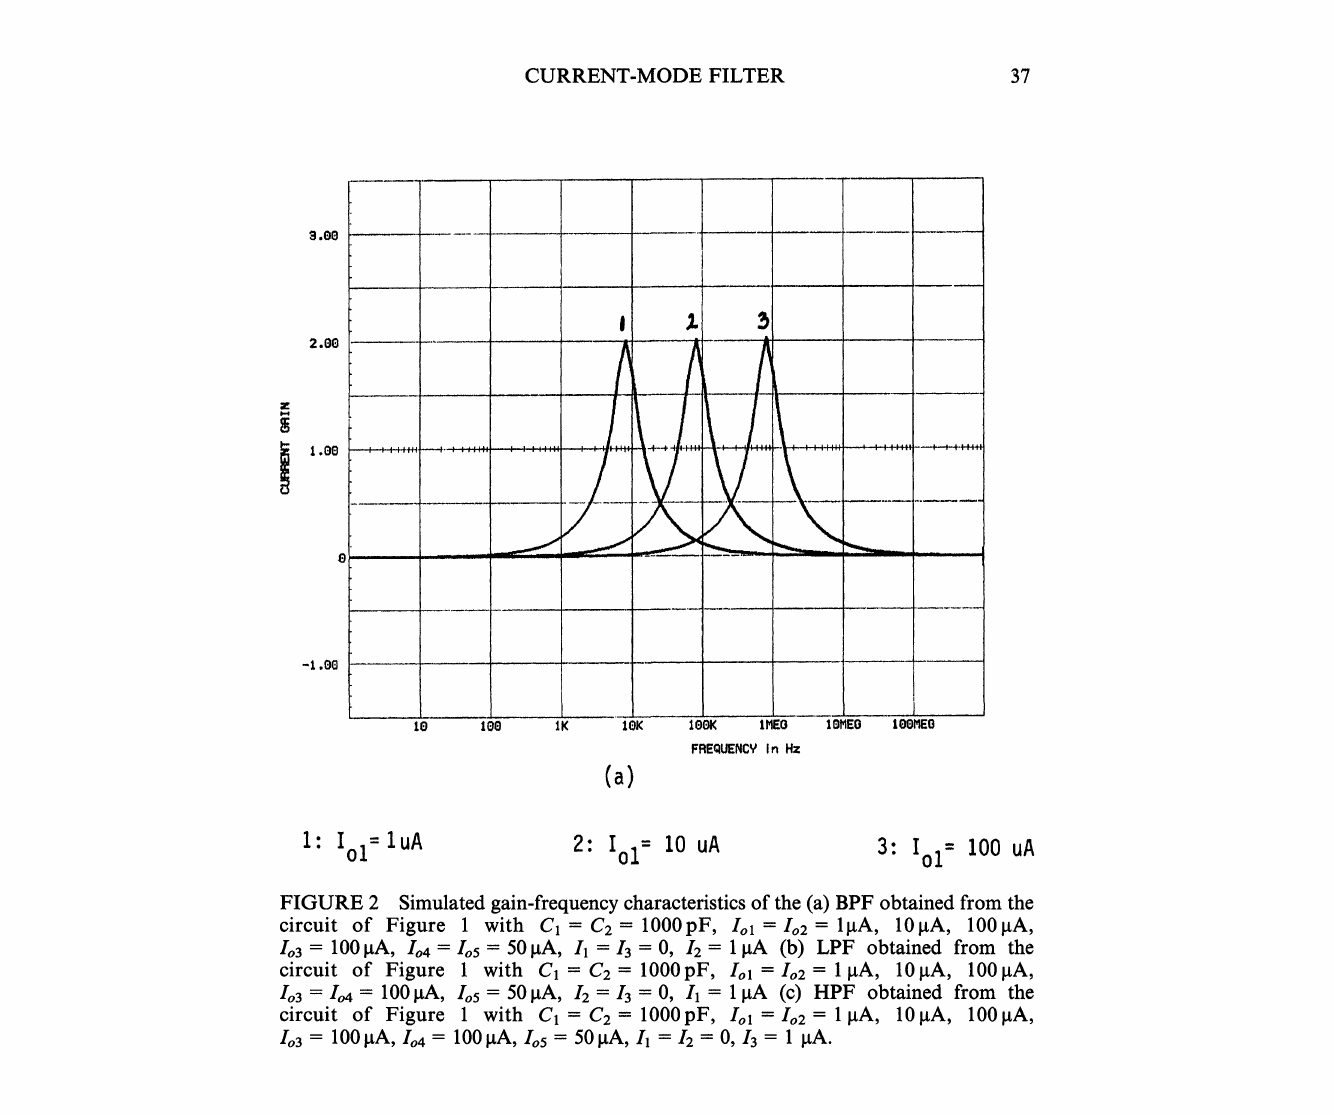
FIGURE 2 Simulated gain-frequency characteristics of the (a) BPF obtained from the circuit of Figure with C1 C9‘= 1000pF, /.ol =/’02 lpA, 10pA, 100pA, lo3 pA (b) LPF obtained from the circuit of Figure with C1 =C9‘= 1000pF, /.ol =1o9- pA (c) HPF obtained from the circuit of Figure with C1 =C9‘= 1000pF, /.ol =1o9‘ pA, 10pA, 100pA, Io3